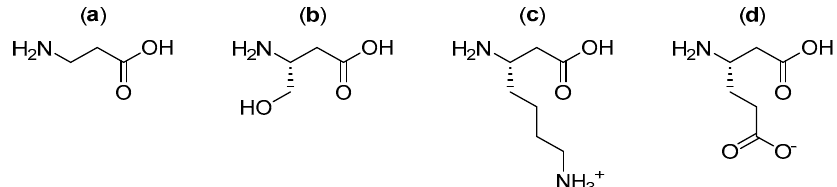
Figure 10. Alternate β -amino acids ( a ) β -alanine; ( b ) β 3 -homoserine; ( c ) β 3 -homolysine; and ( d ) β 3 -homoglutamic acid investigated by Garayoa et al. for use as linkers [17].